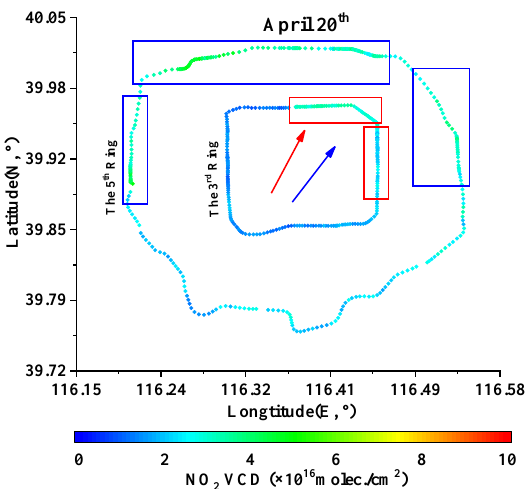
Figure 11. The NO 2 VCD spatial distribution of the fifth ring and third ring on April 20th (The blue arrow is the averaged wind field of the fifth ring. The red arrow is the averaged wind field of the third ring).